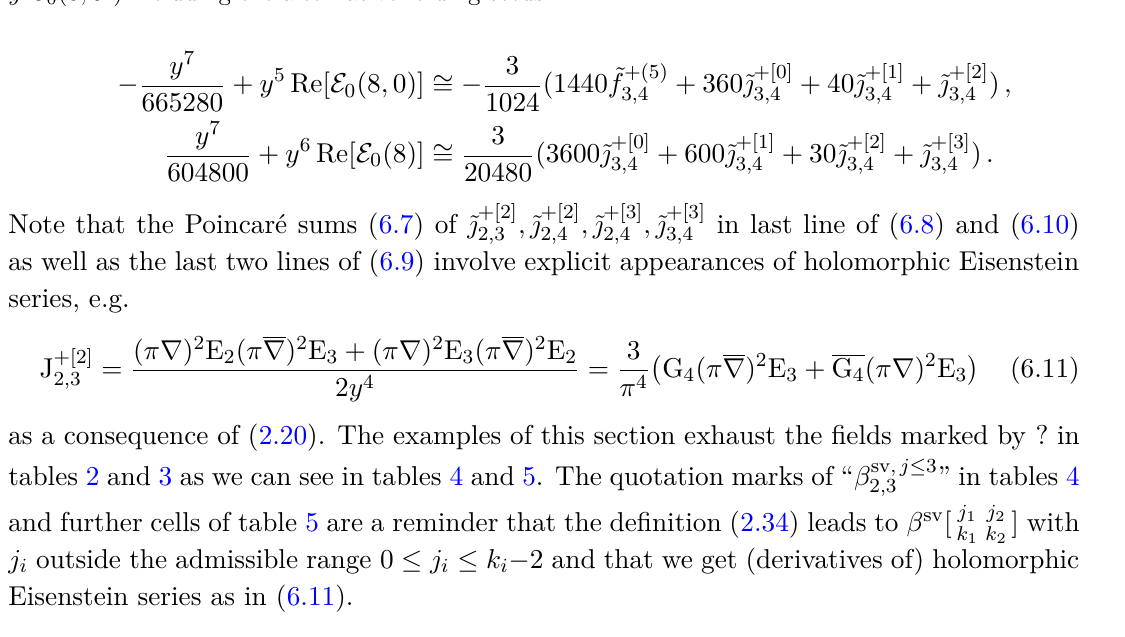
Table 4 . Leading-depth terms β sv ,j y a E 0 (6 , 0 b ) including the alternative folding